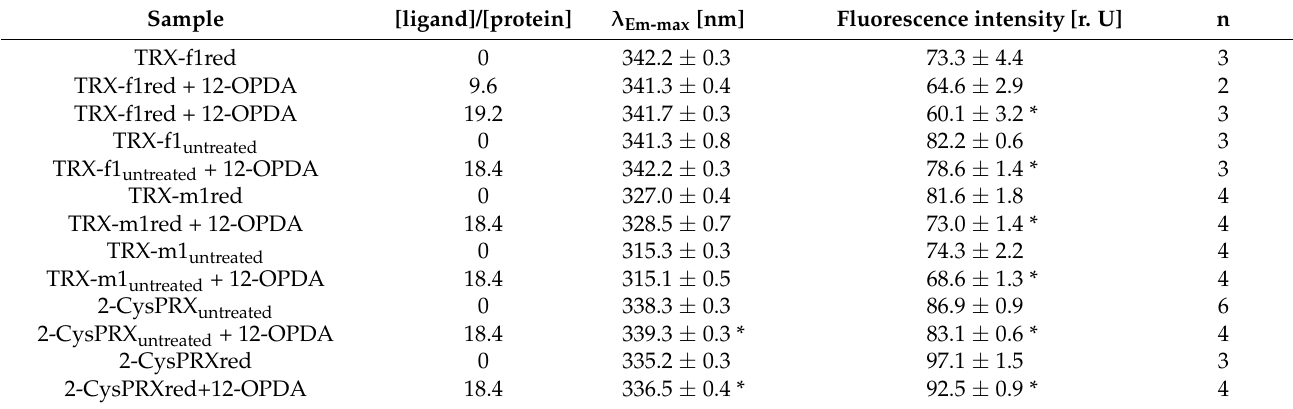
Table 2. Analysis of interaction between TRX-fold proteins and 12-OPDA via protein fluorescence. Data are from experi- ments similar to the one presented for TRX-f1red, untreated TRX-f1 , TRX-m1red , untreated TRX-m1, 2CysPRXred , untreated 2CysPRX ± 12-OPDA in Figure S3. Results are presented as means ± SD, n is given in the last column. Asterisks indicate significant differences at p ≤ 0.05 in comparison to samples incubated with plain solvent. The fluorescence intensity [r. U.] result of sample TRX-f1red + 12-OPDA at a ligand/protein ration of 9.6 in comparison to TRX-f1red showed a trend, but was insignificant ( p = 0.11). Statistical evaluation employed one-way ANOVA with post-hoc Tukey HSD test. For details, see Section